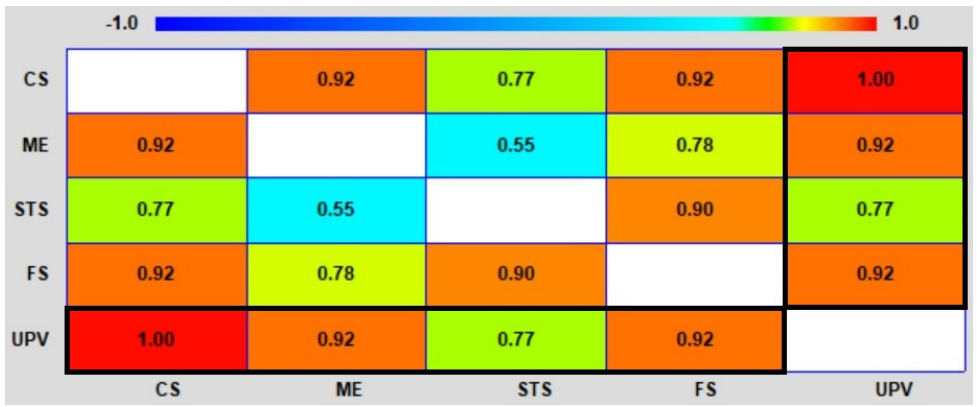
Figure 6. Spearman correlation matrix. Correlations between UPV readings and mechanical prop- erties marked within the thick black border.